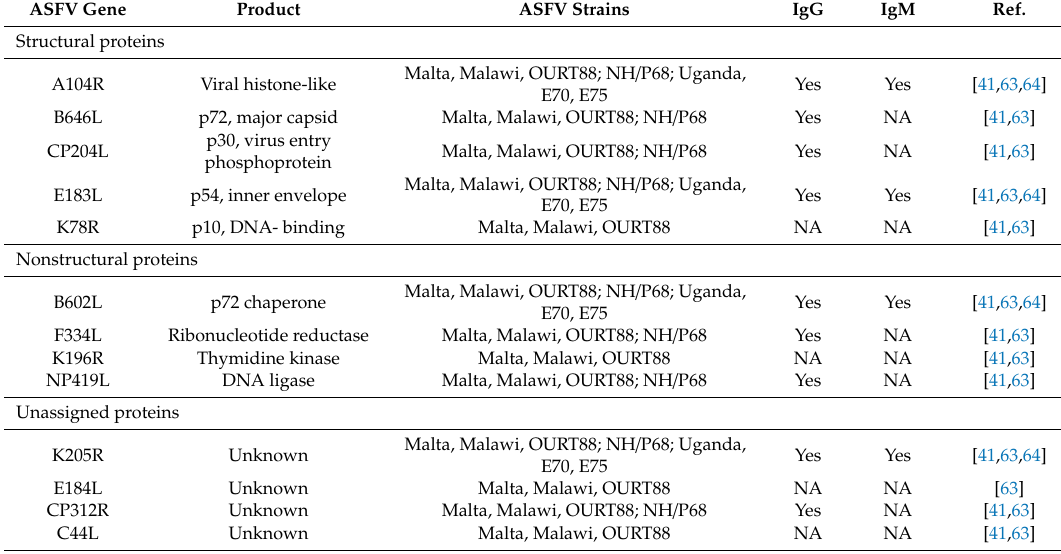
Table 5. Antigens recognized by ASFV infected pig